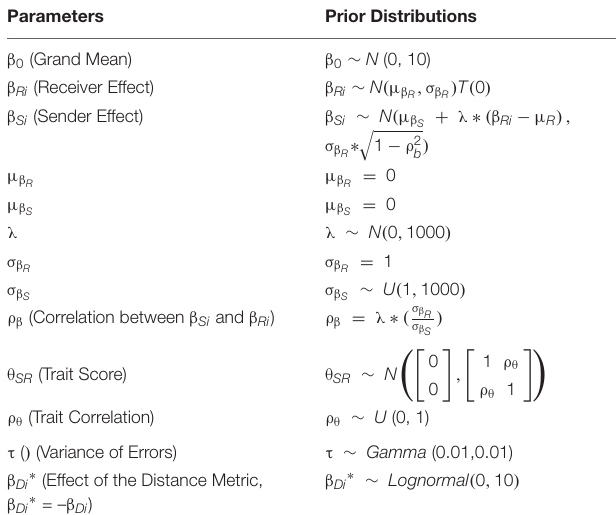
TABLE 4 | Prior distributions for model